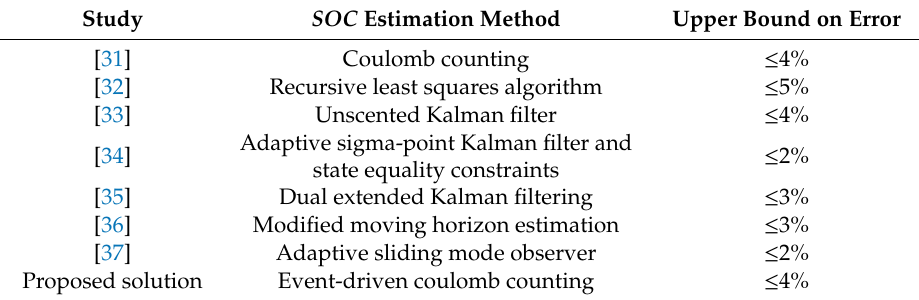
Table 4. Comparison with contemporary